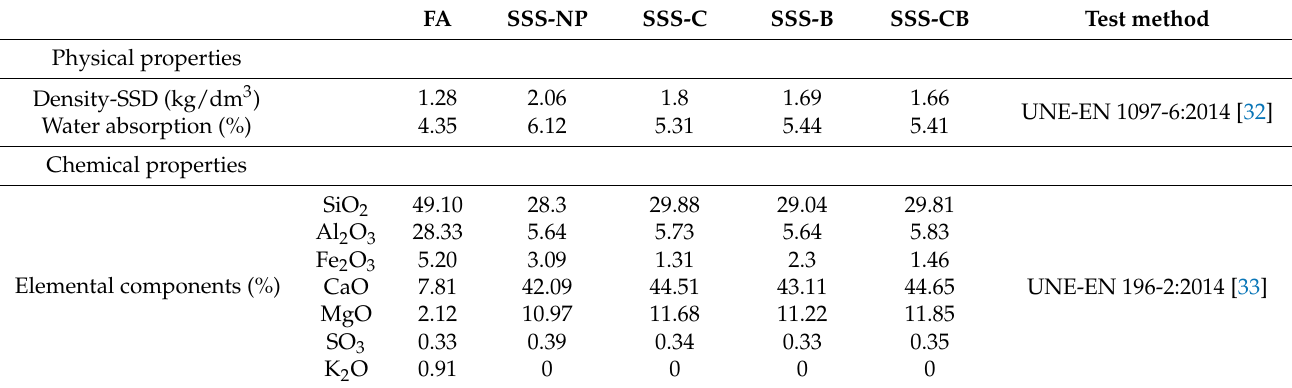
Table 1. Physical and chemical properties of